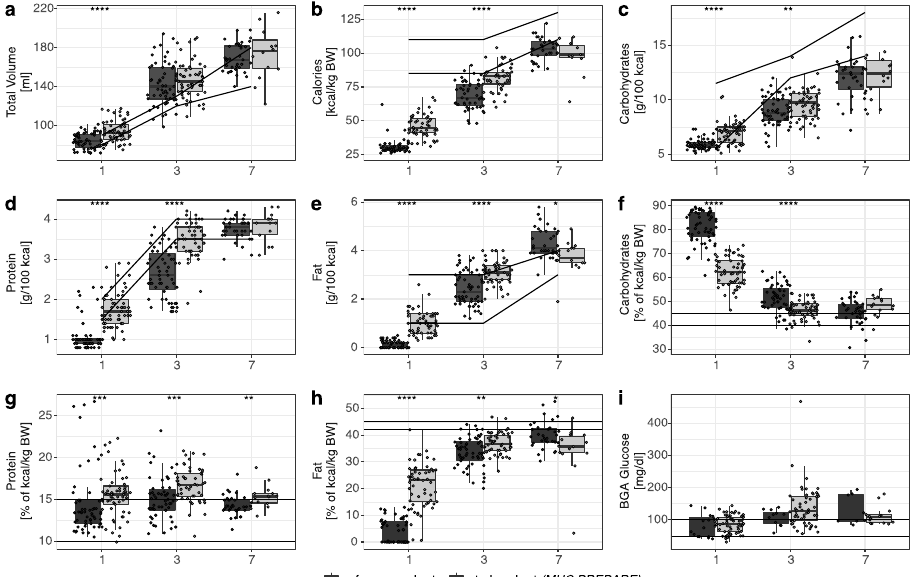
Figure 1. Comparison between the reference cohort (dark grey) and the study cohort (light grey; MUC PREPARE ) for ( a ) total volume (mL), ( b ) calories (kcal/kg BW), supply shown in g/100 kcal for ( c ) carbohydrates, ( d ) protein, and ( e ) fat, ( f – h ) supply expressed as percentage of total calorie intake supply. ( i ) BGA glucose levels (mg/dL). Recommendations are shown as horizontal lines (ES-